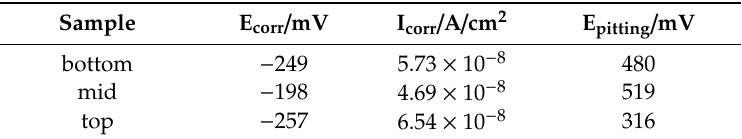
Table 3. The test results of potentiodynamic polarization curve (corrosion potential, corrosion current density, and pitting